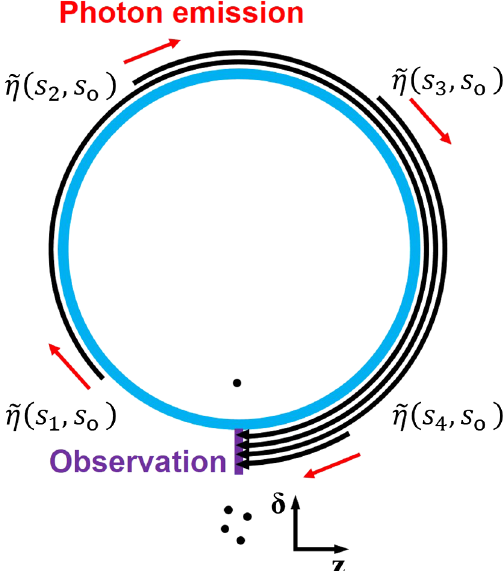
FIG. 3. Physical pictures of partial phase slippage and quantum excitation. Particles undergo diffusion in both the particle energy and the longitudinal coordinate in each turn, giving rise to longitudinal emittance, as a result of quantum